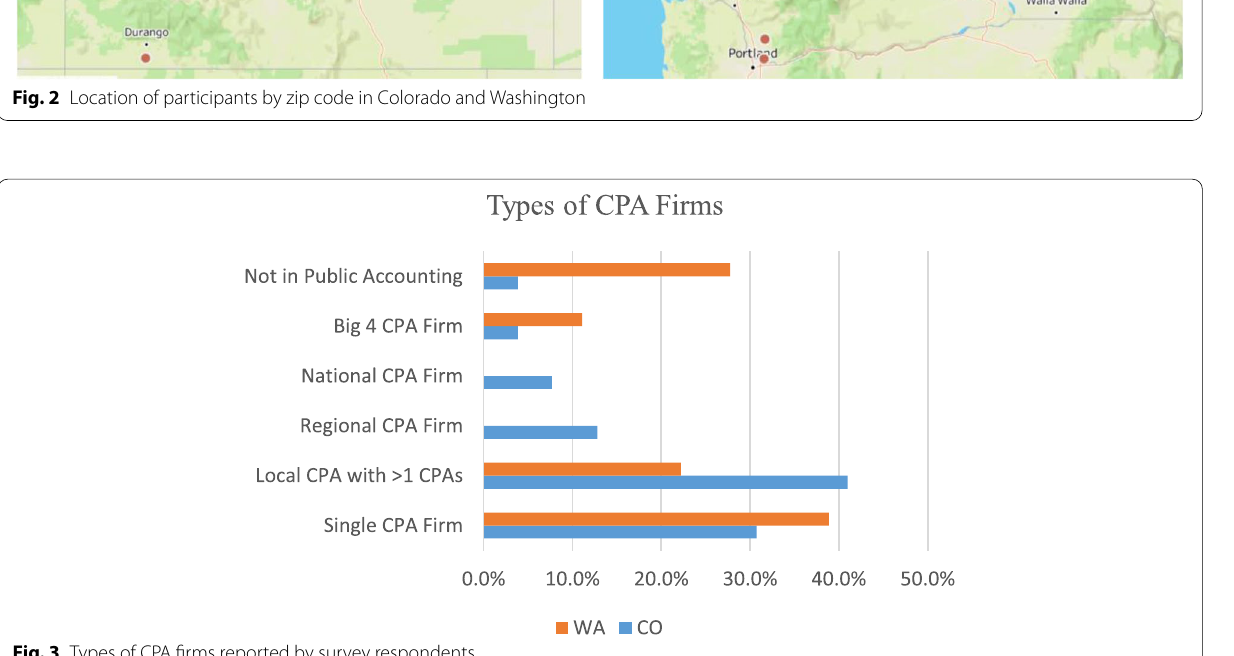
Fig. 3 Types of CPA firms reported by survey